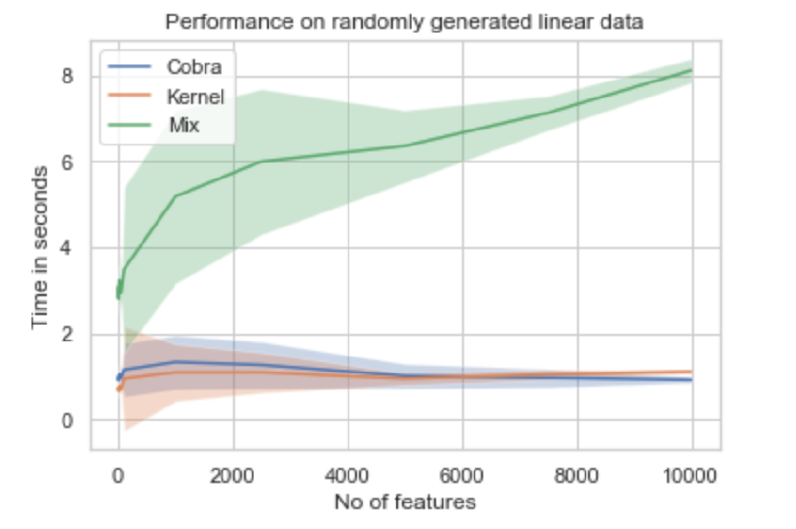
Figure 1. CPU timing for building the initial COBRA, MixCobra and KernelCobra estimators. Each line is an average over 100 independent runs, and shaded areas show standard